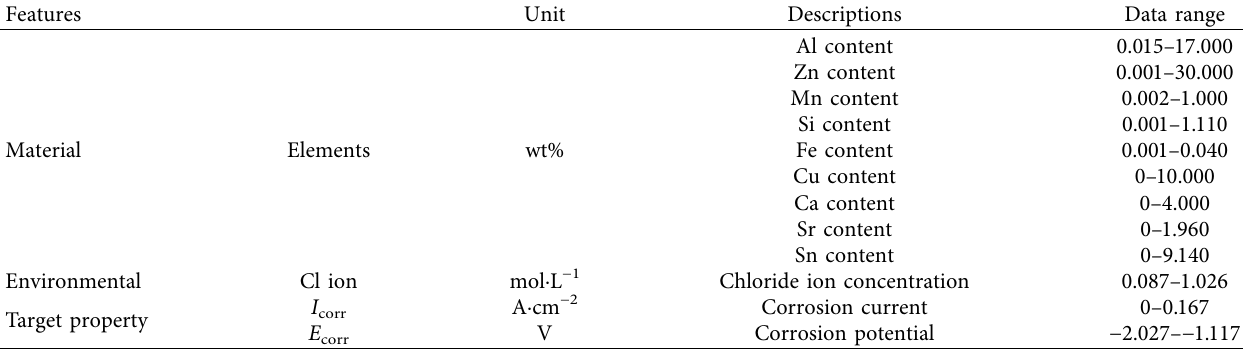
Table 1: Chemical composite features, environment features, and target attributes.